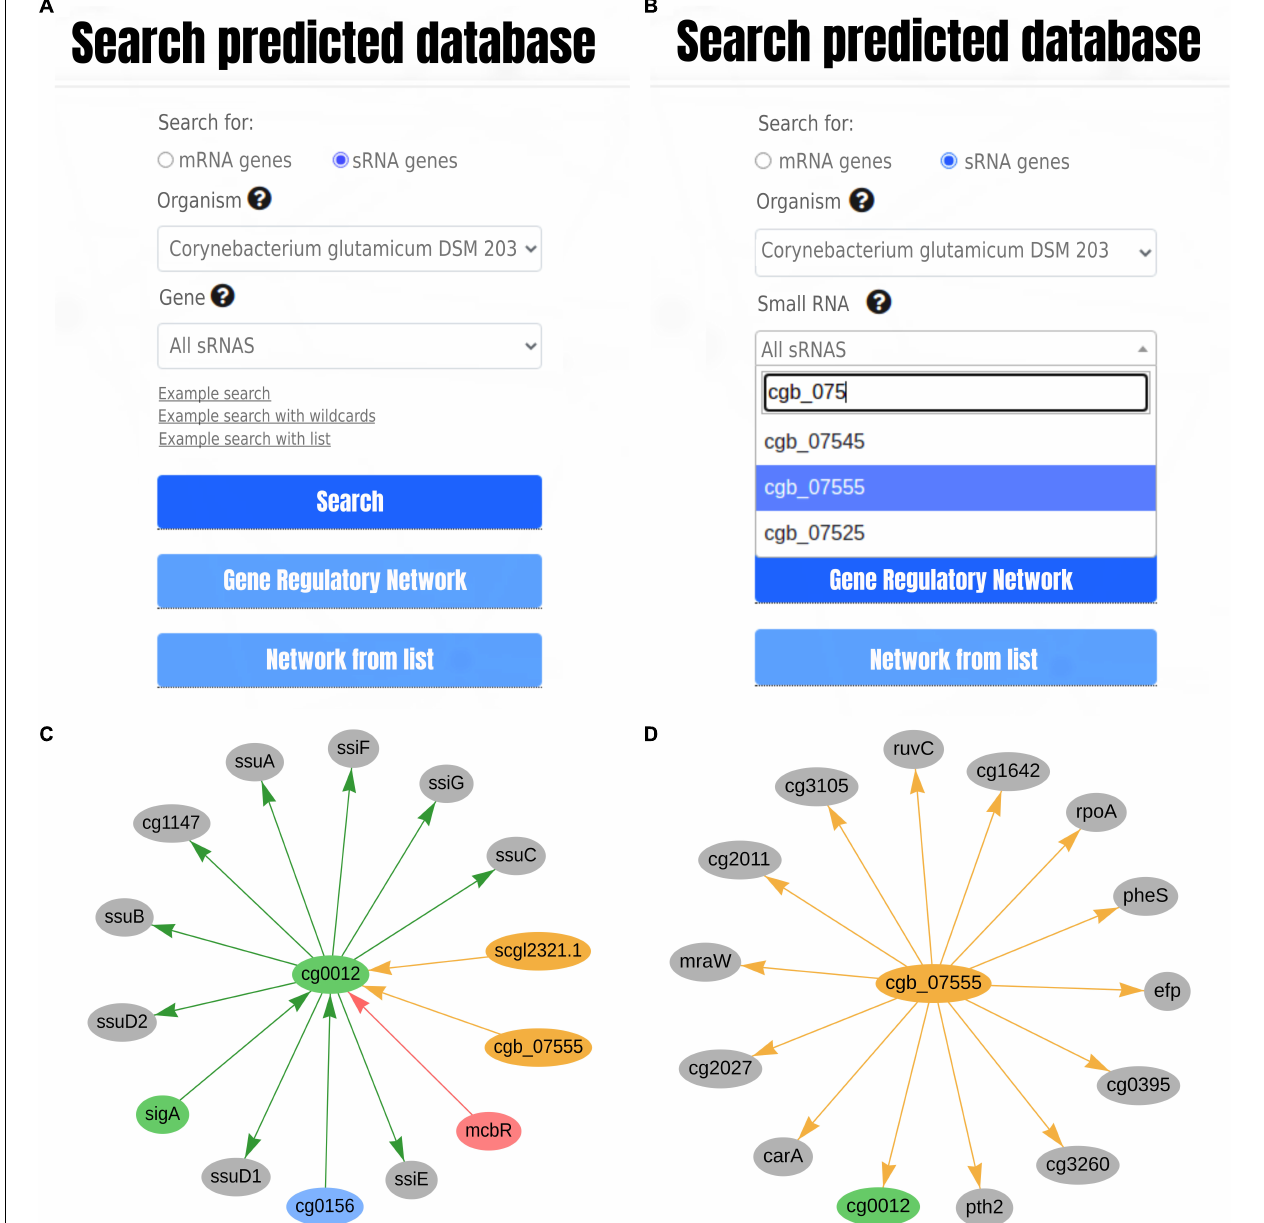
FIGURE 2 | CoryneRegNet’s front-end updates in (A,B) search page and (C,D) in the network visualization. (A) The search page of CoryneRegNet’s database allows for choosing between searching for mRNA genes or sRNA genes while (B) guiding the search with gene or sRNA identifiers. (C) Direct regulations of cg0012 and (D) genes regulated by cgb_07555. In the network, green nodes represent activator proteins, red nodes represent repressor proteins, blue nodes represent dual regulators (i.e., that can activate and repress gene expression), orange nodes represent sRNAs and gray nodes represent target genes. The arrows represent the regulatory interactions and their colors represent the same roles as in the